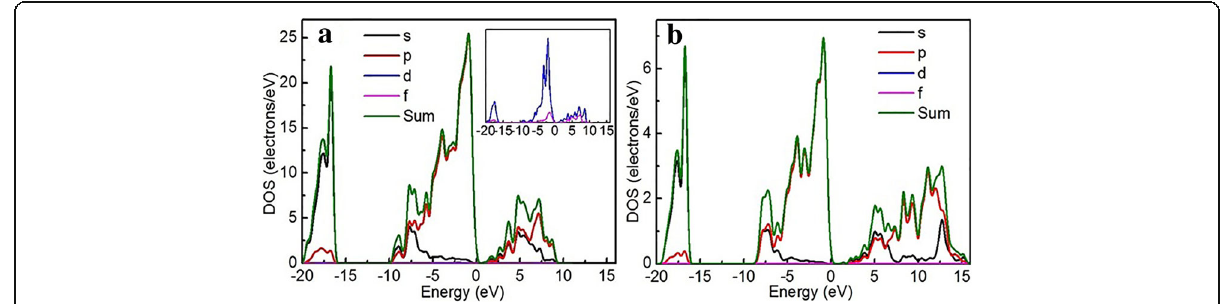
Fig. 8 Density of states of a Eu-SnO 2 and b SnO 2